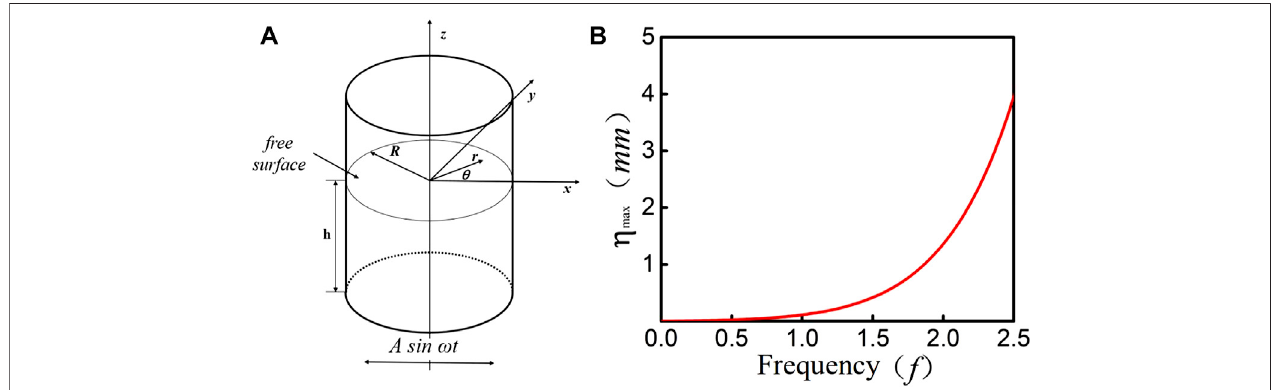
FIGURE 4 | (A) Cylindrical tank under sinusoidal lateral excitation. (B) Relationship between maximum wave height η max and external excitation frequency ω .